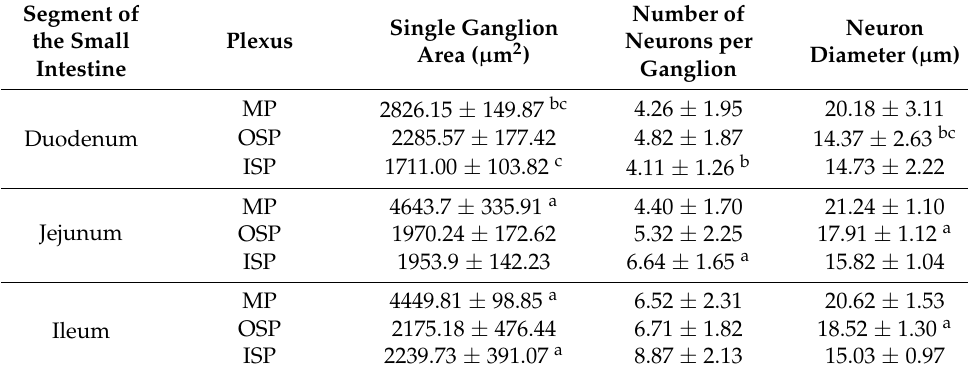
Table 2. Morphometrical analysis of enteric neurons showing simultaneous IR to Hu C/D and P2X2 in different segments of the porcine small intestine (mean ± S.D.). Statistically significant differences ( p < 0.05) between the different parameters of analogous nerve plexuses of different segments of the small intestine are marked: a vs. duodenum, b vs. jejunum, c vs. ileum. Segment of Single Ganglion the Small Plexus Area ( µ m 2 Intestine